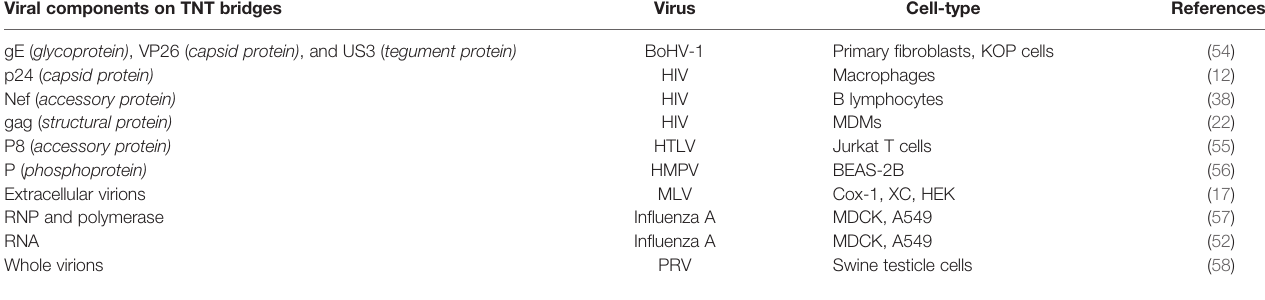
TABLE 1 | List of the viruses and the viral components including the cell-type associated with TNT bridges are listed. Viral components on TNT bridges